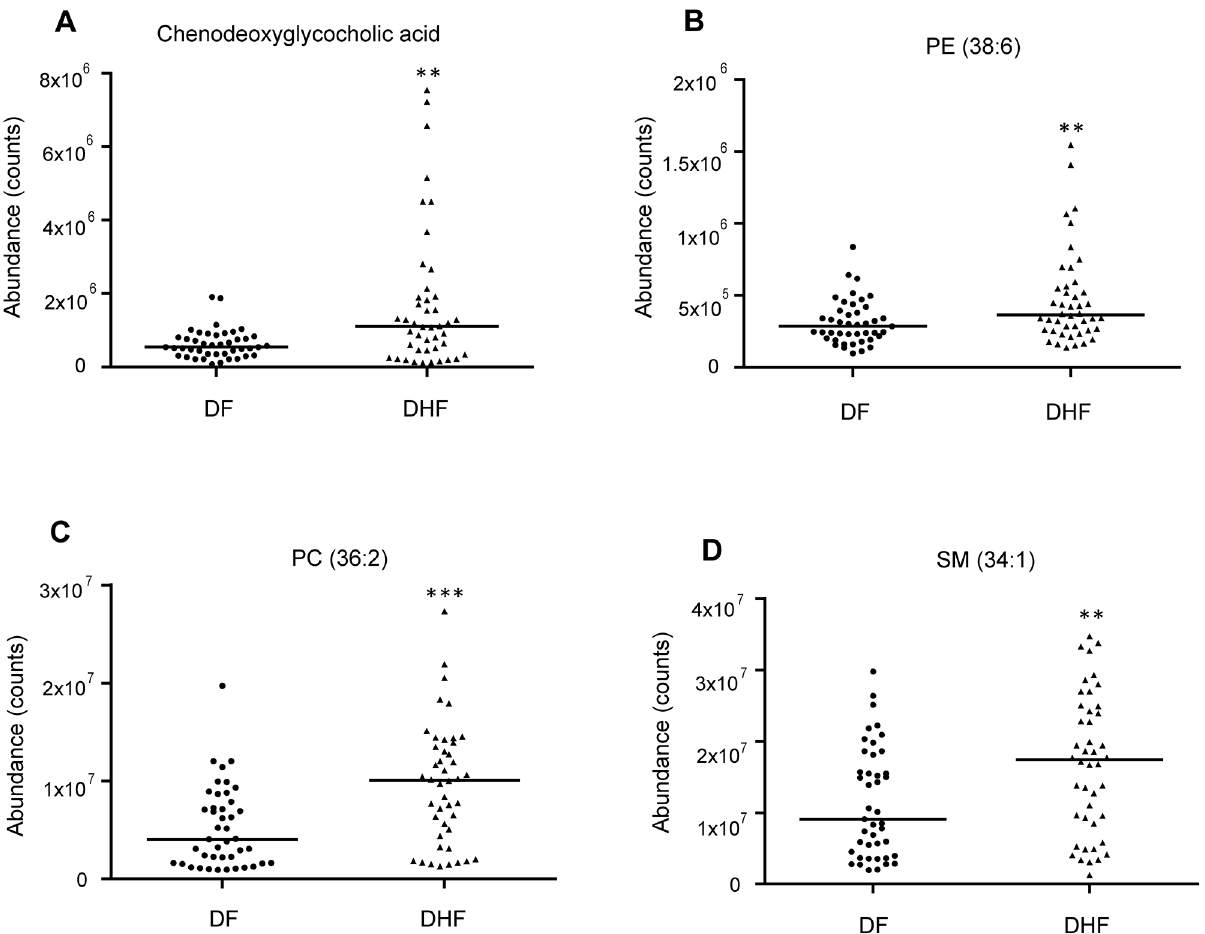
Fig 4. Box plots of representative differentially expressed metabolites between dengue fever (DF) and dengue hemorrhagic fever (DHF) patients during recovery phase. A. Chenodeoxyglycocholic acid B. PE (38:6) C. PC (36:2) D. SM (34:1). Horizontal lines represent median value. (cid:3) p < 0.05, (cid:3)(cid:3) p < 0.01, (cid:3)(cid:3)(cid:3) p < 0.001, by Mann-Whitney test. The statistical comparison was with DF levels.